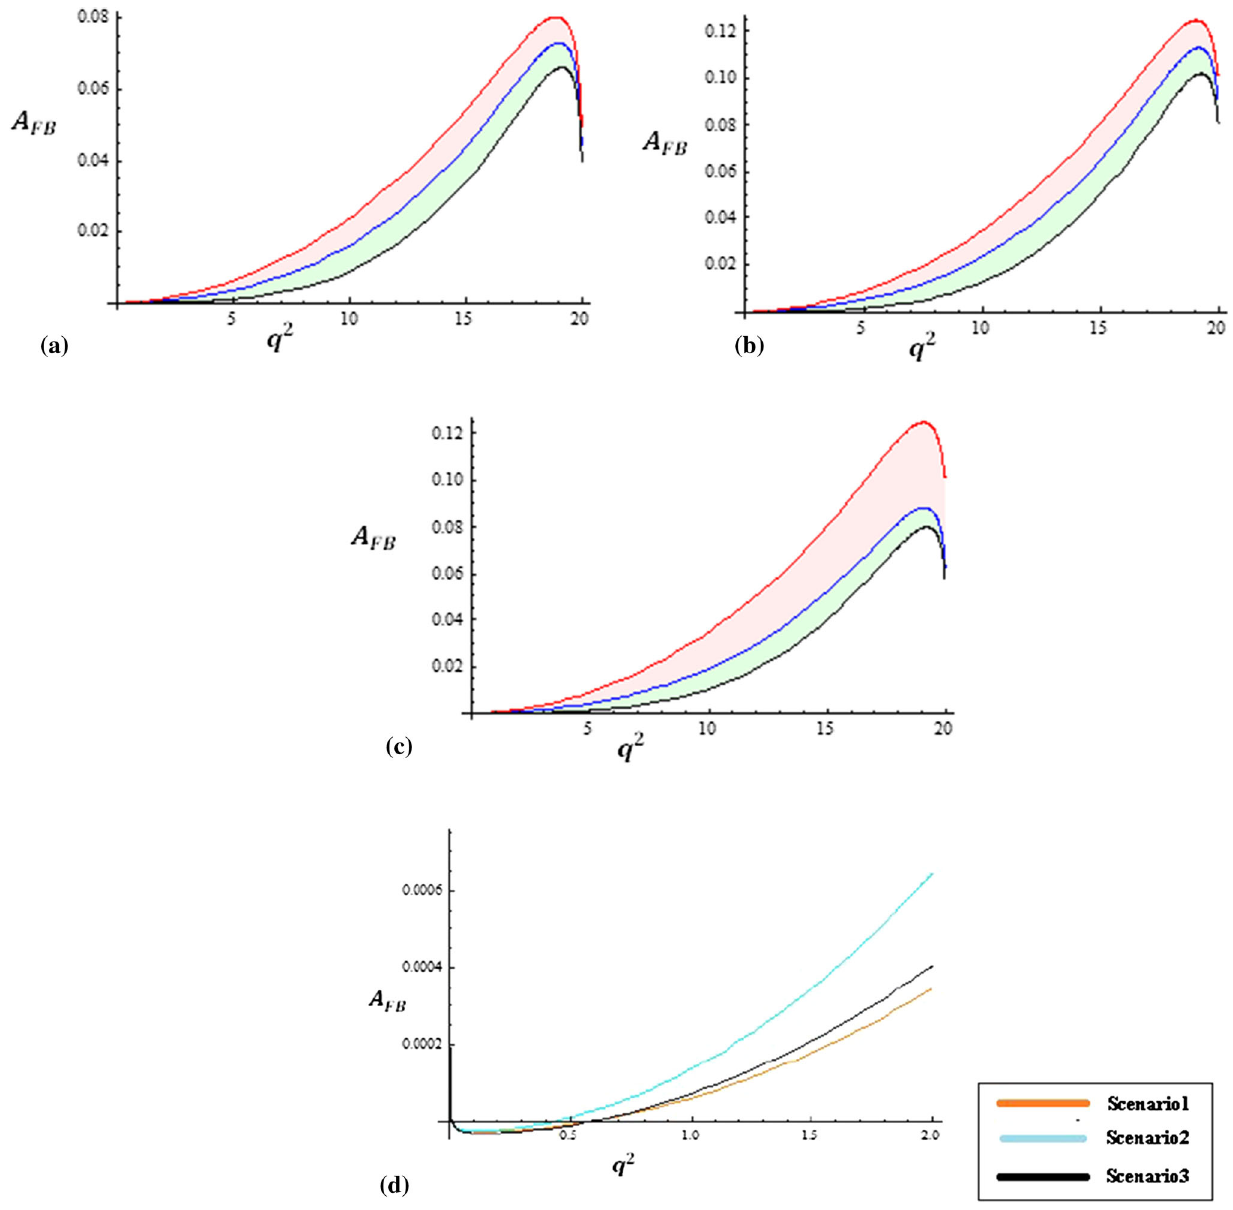
Fig. 3 Variation of lepton side forward backward asymmetry for (cid:2) → (cid:2)μ + e − within allowed kinematic region of q 2 using the bound b ofNP couplings for a scenario1, b scenario2and c scenario3. 3d:Vari-